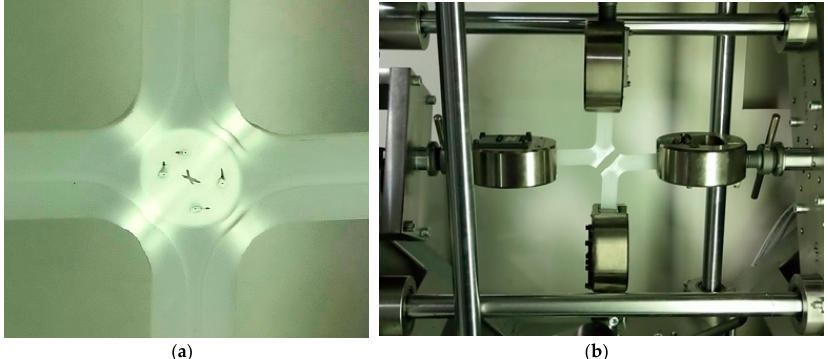
Figure 19. Load–displacement response measured in the biaxial tensile tests (solid curves—horizontal axis; dashed curves—vertical axis). However, after the tests it was seen that failure did not start in the measurement zone, in the center, but actually in the areas around it, where there were stress concentrations (Figure 20). This shows that the chosen specimen geometry is not well-suited for determining the stress–strain curves up to failure. Nevertheless, as expected from the biaxial load combination, imposed failure took place at a 45° orientation relative to the loading axes.